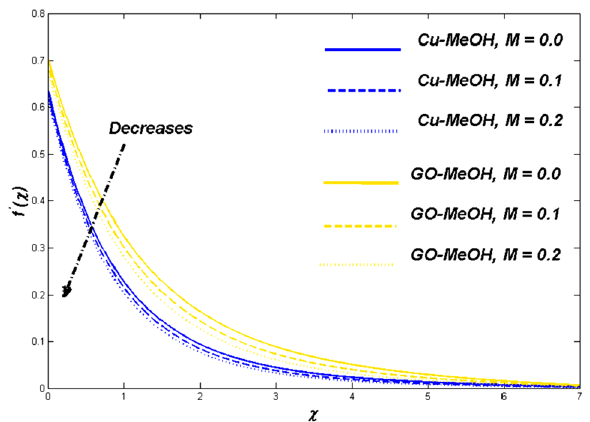
Figure 7. Velocity variation versus M .